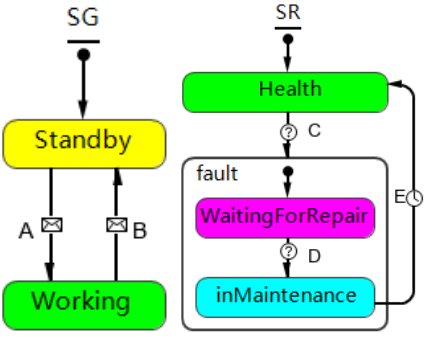
Figure 7. The statechart for equipment agent.